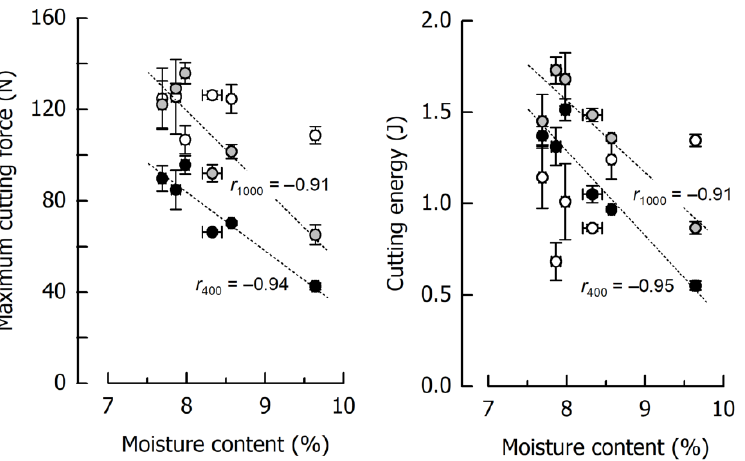
Figure 5. Correlations of maximum cutting force and cutting energy with moisture content at 400 mm/min (black), 1000 mm/min (grey), and 2500 mm/min (white) for the caramel reference formulation. Data are arithmetic means ± standard deviation for maximum cutting force or cutting energy ( n = 4) and for moisture ( n = 3).